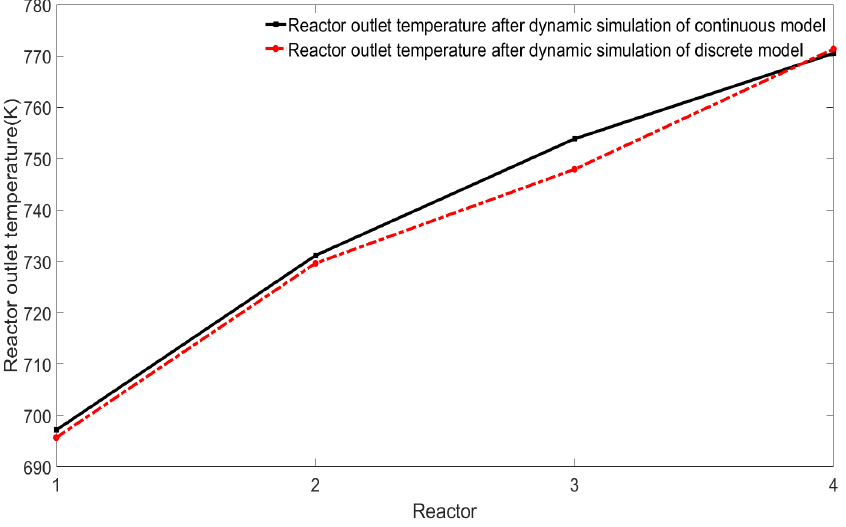
Figure 6. Comparison of the outlet temperature of each reactor after the dynamic simulation of the discrete model and the continuous